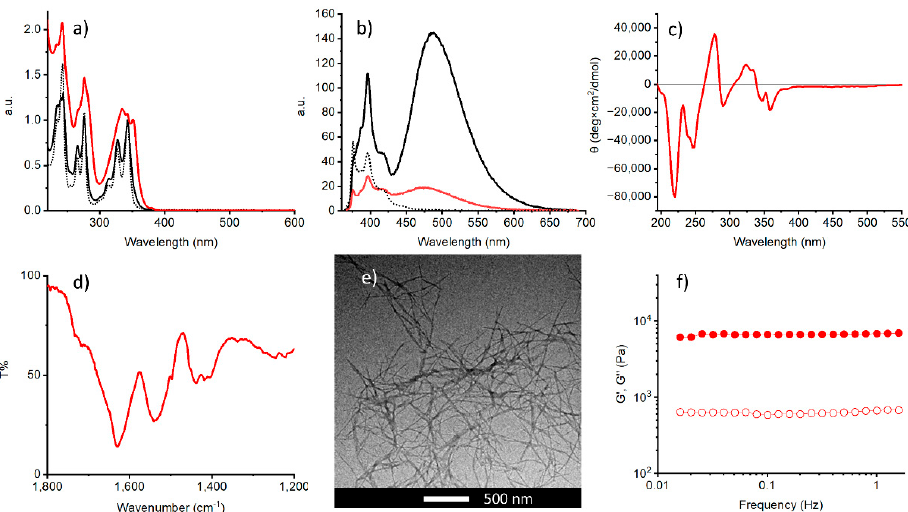
Figure 2. ( a ) UV-Vis absorption and ( b ) emission spectra of the pH-triggered gel (red line) and the aqueous solutions of 1 at 0.5% (solid black line) and 0.005% concentration (black dotted line); ( c ) ATR-FTIR, ( d ) CD spectrum, ( e ) TEM images and ( f ) frequency sweep experiment of the HCl triggered gel at 0.5% concentration, G’ is indicated with filled circles and G’’ with open circles. ATR-IR and TEM were recorded using dried samples.